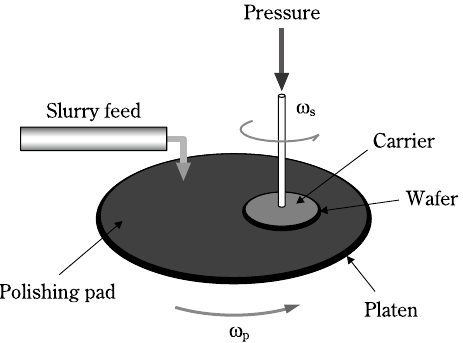
Fig. 1. Schematic of CMP process; ω s and ω p refer to angular velocity of carrier and platen respectively. (Fig. 1 from reference 7; Repro- duced by permission of the MRS